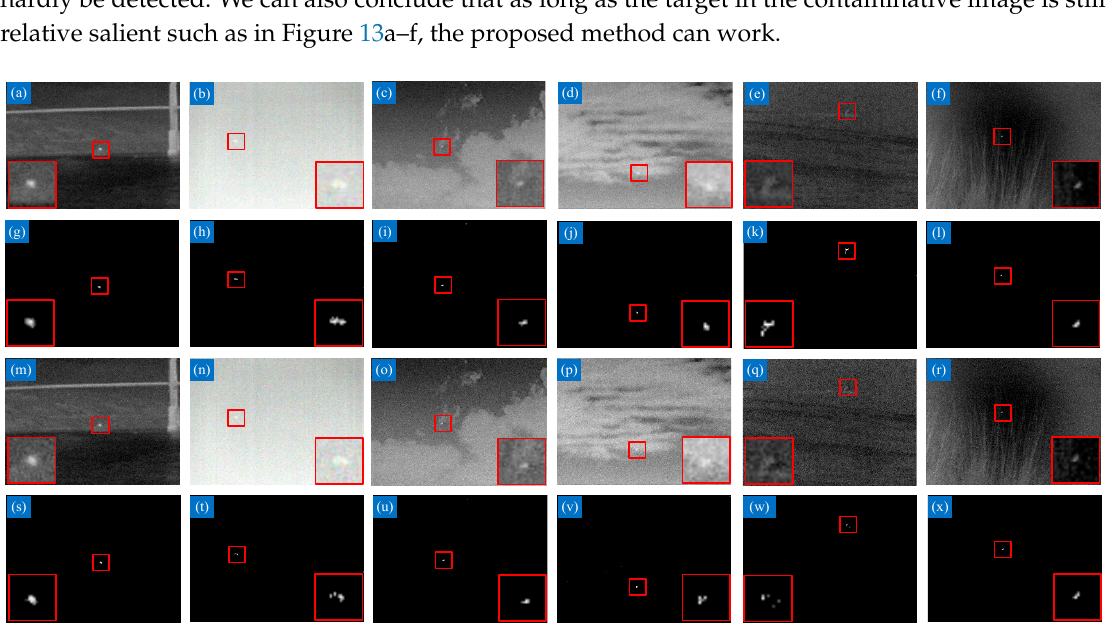
(v) Figure 14. The first and third row are infrared images with additive white Gaussian noise with standard deviations of 10 and 20, and the second and fourth rows are the corresponding detection results by the RIPT method. 4.4.3. Visual Comparison with Baselines To further visually compare the performance of all the competing methods, the results obtained by all the tested methods on Sequences 1–4 are displayed in Figures 15–18, and the detailed descriptions of four sequences are shown in Table 4. Note that for the convenience of observation, the contrast of the results obtained by Top-hat, LoG and RLCM is adjusted. For conventional Top-hat transformation, it can highlight the target to a certain extent in Figures 15(a)–18(a); however, it is extremely sensitive to noise and clutters, which would produce many false alarms. The intrinsic reason is mainly relevant to the usage of the fixed structural element without considering the surrounding neighborhood. Besides, the fixed structural element with a fixed shape is difficult to perfectly match all the targets. LoG, MPCM and RLCM are all HVS-based approaches but the